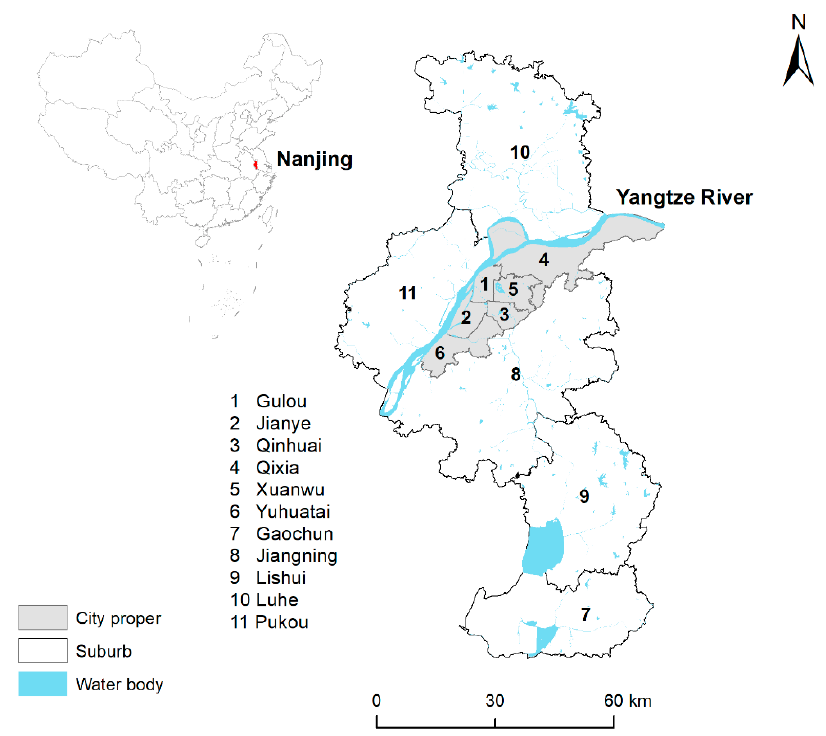
Figure 2. Study area—Nanjing, China.